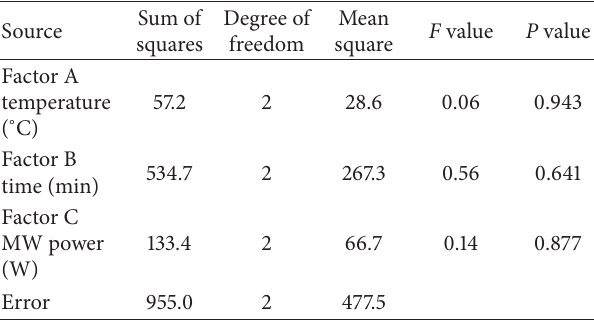
Table 9: Variance analysis of orthogonal experiment on synthesis of isopropyl 𝛽 -(3,4-dihydroxyphenyl)- 𝛼